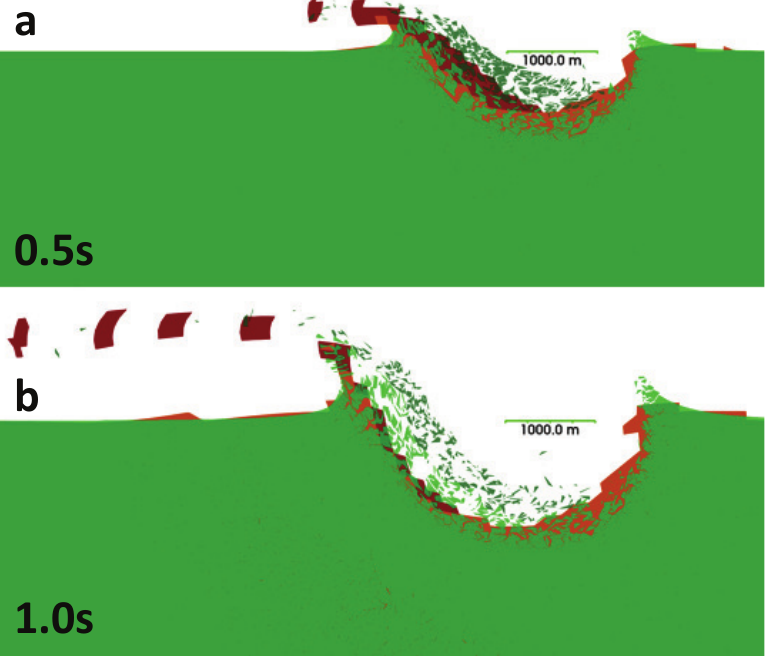
Figure 8. FLAG and HOSS simulations overlaid to show differences in the crater profiles from a 5 km/s oblique impact at ( a ) 0.5 s and ( b ) 1.0 s. The FLAG simulations are represented with an orange target material and red impactor. HOSS simulations are shown with a green target material and dark green impactor. The length of the horizontal green bar shown inside the crater represents a distance of 1000